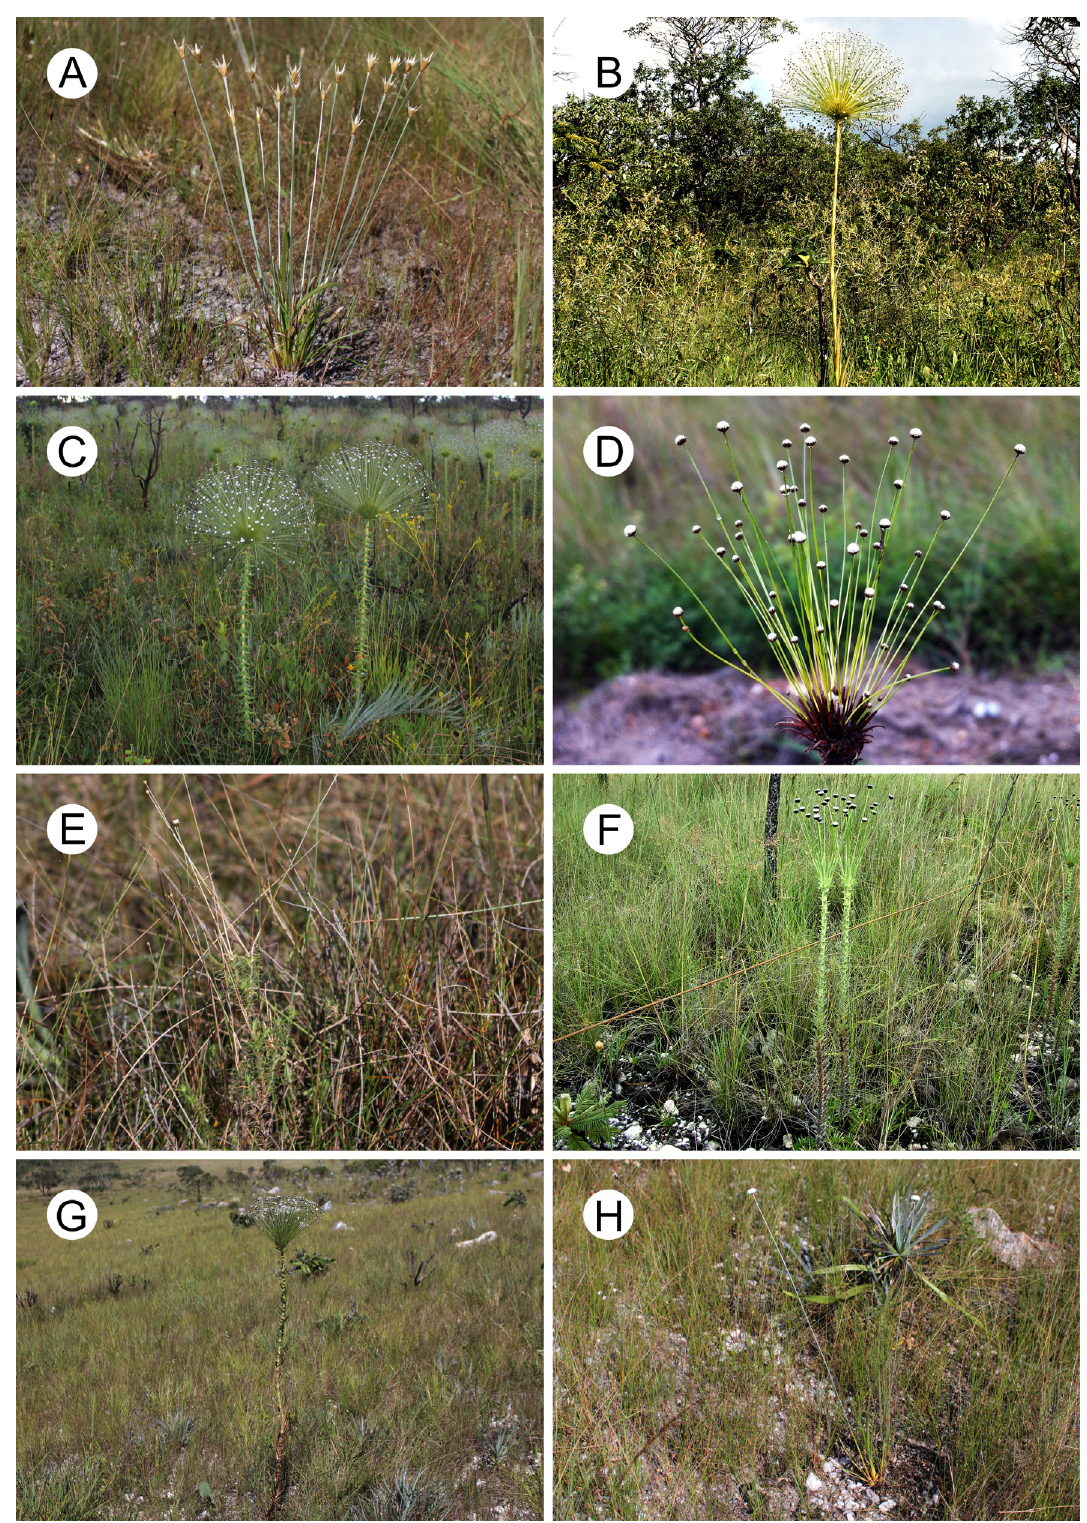
Fig. 7. Species of Paepalanthoideae (Eriocaulaceae) from the Chapada dos Veadeiros National